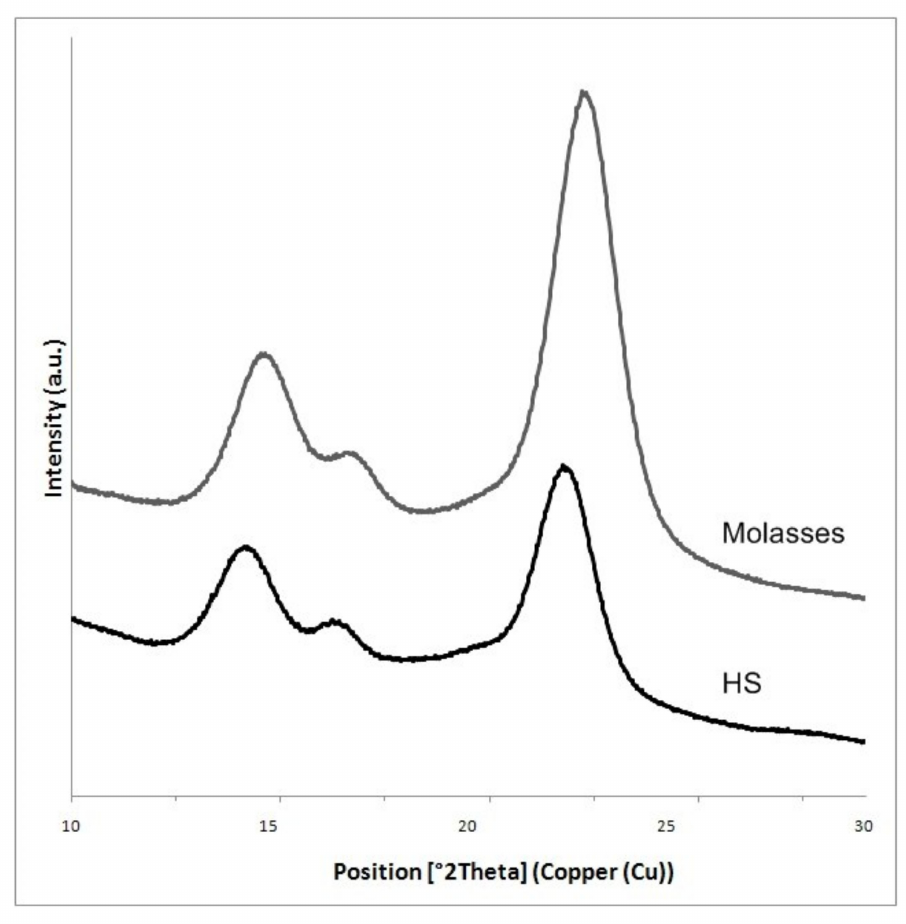
Figure 3. XRD patterns of BC obtained from HS medium and